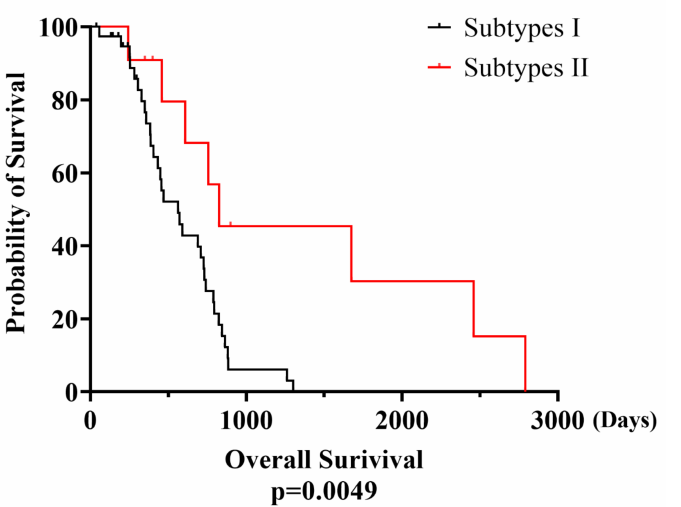
Figure 4. Kaplan–Meier plot for survival time of subtype I patients (Red) and subtype II patients (black).